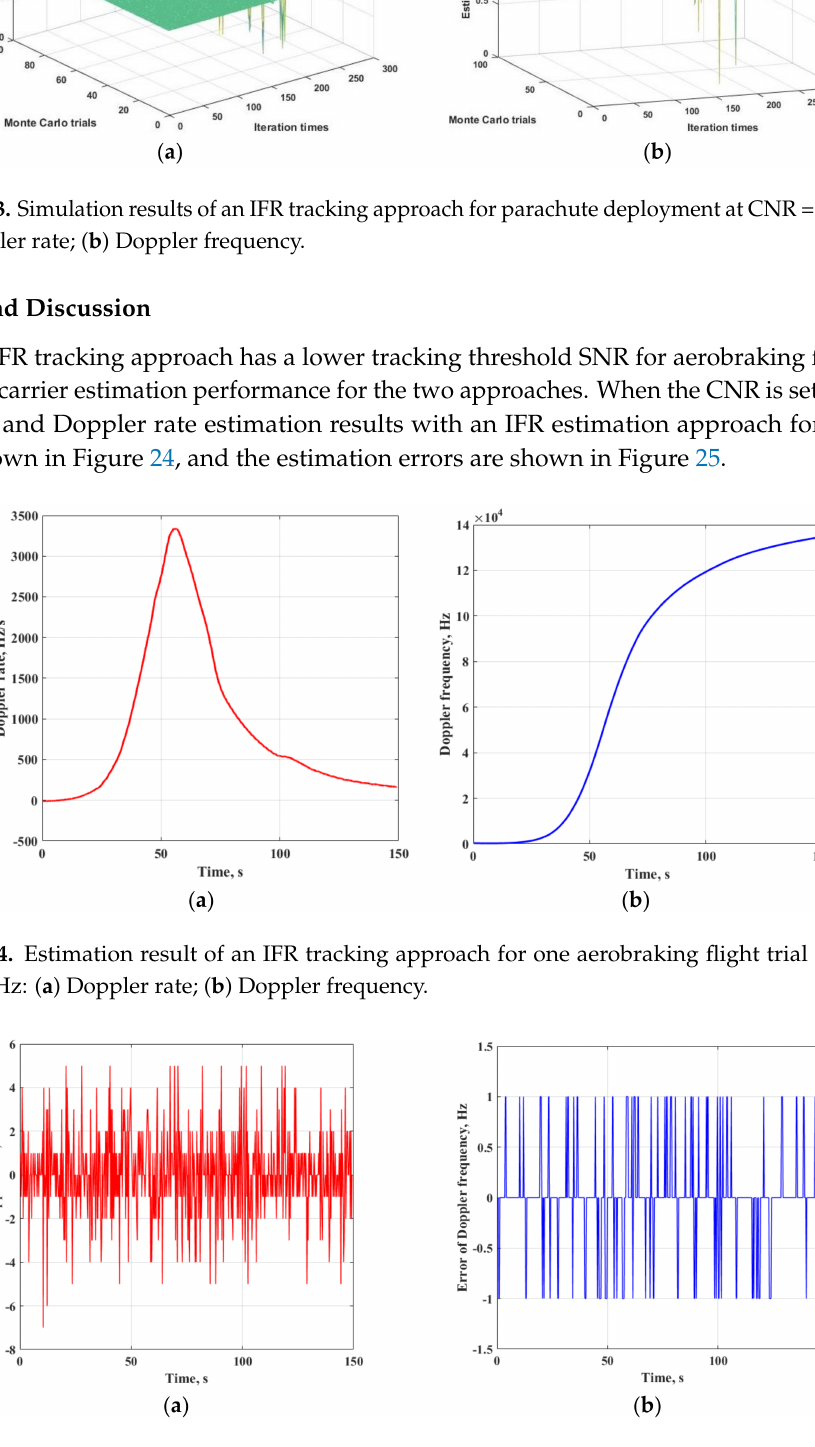
Figure 25. Estimation errors of an IFR tracking approach for one aerobraking flight trial at CNR = 22.6 dB-Hz: ( a ) Doppler rate errors; ( b ) Doppler frequency